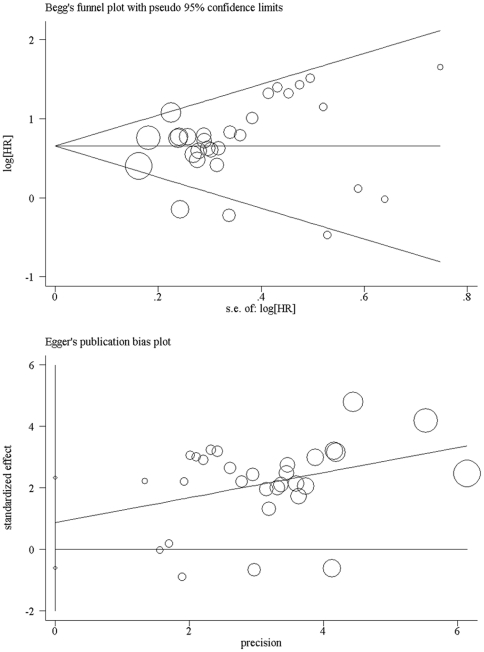
Funnel plots of Begg's and Egger's were used to detect publication bias on overall estimate.Studies are distributed symmetrically above and below the horizontal line, and suggest that the meta-analysis is absence of publication bias.